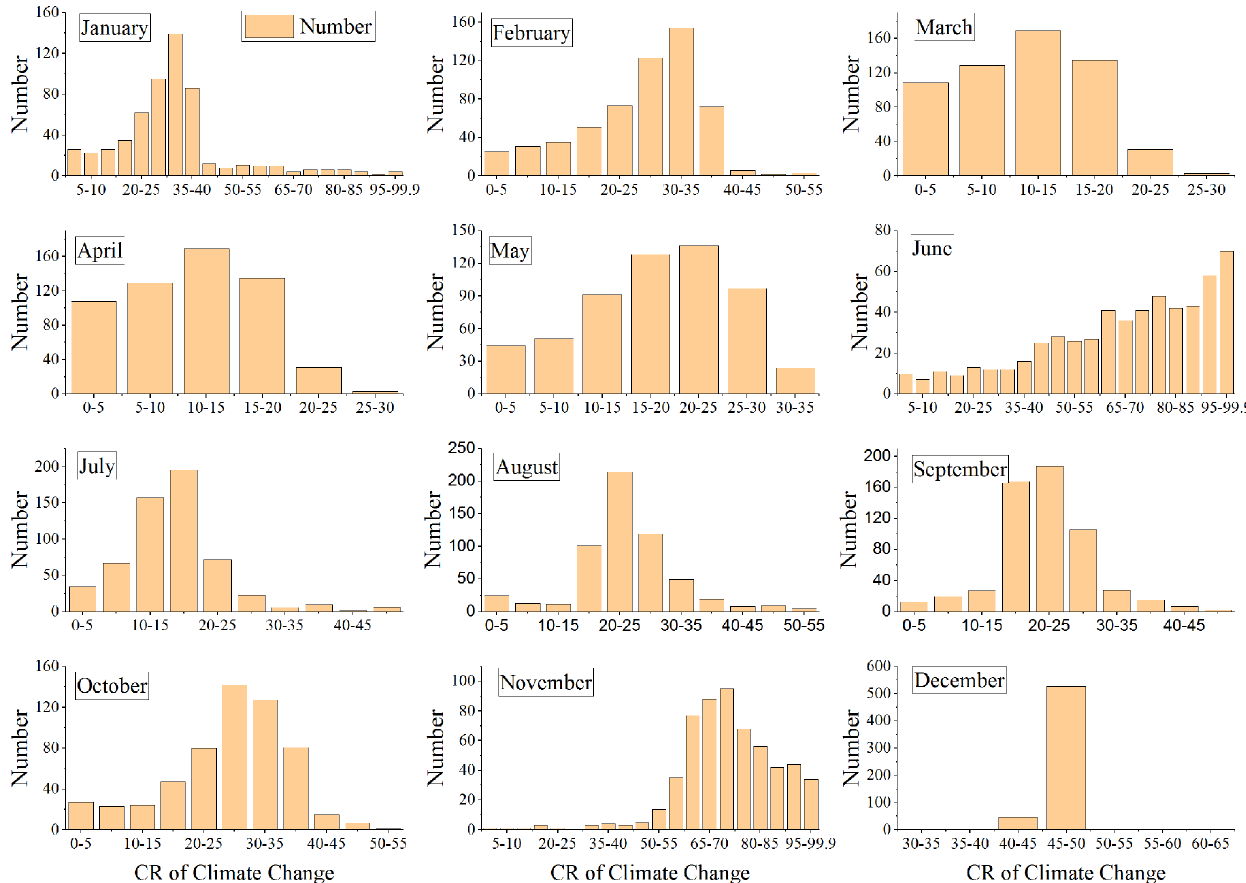
Figure 11. Histogram of the number of simulations of the CR (with a 5% step) of climate change to streamflow reduction in the LR basin on a monthly scale.